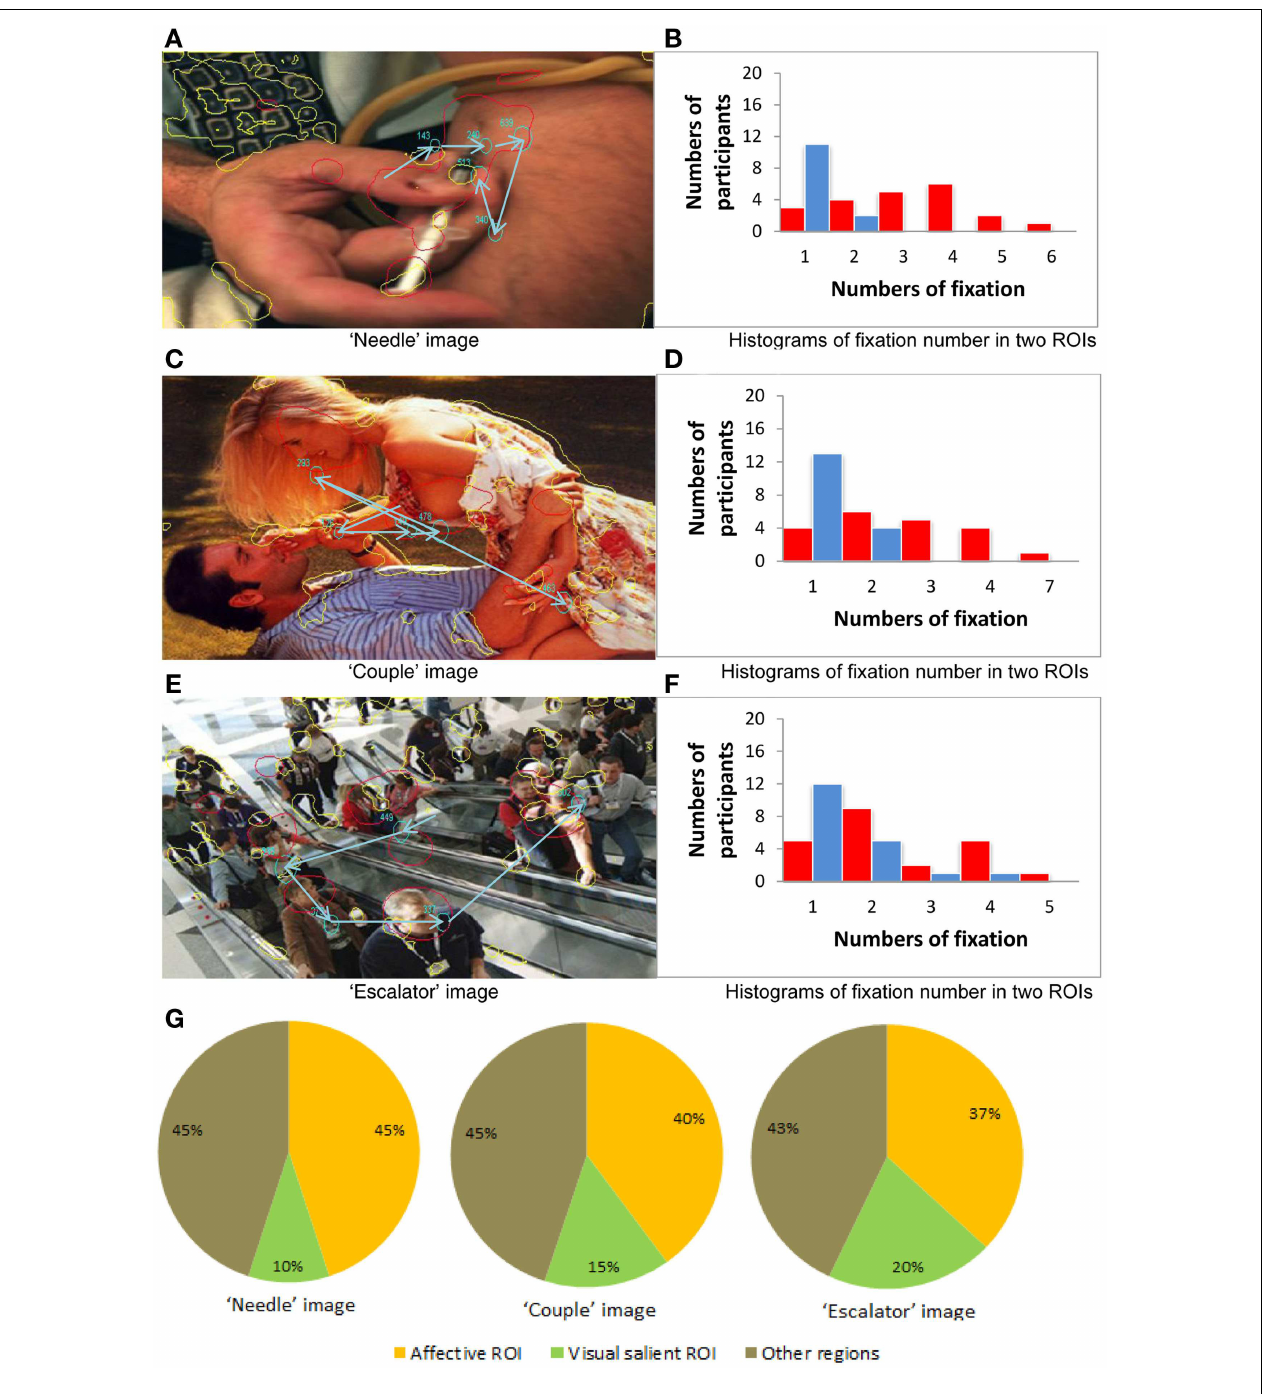
FIGURE 5 | Eye movement behavior analysis of the three example images. (A,C,E) Three example images. (B,D,F) The number of participants with 1–7 fixations in affective vs. visual salient ROIs for each of the example images. (G) Fixation allocation tendency scores across all participants for the example